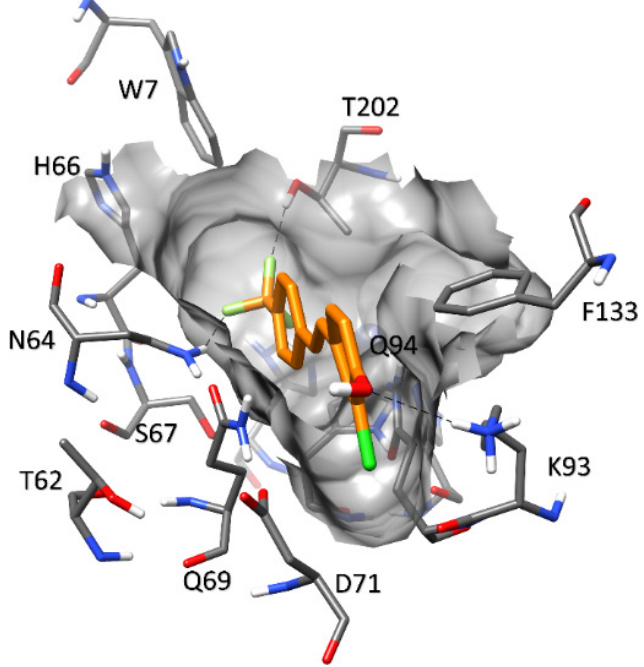
Figure 6. Predicted binding mode of compound 4 in hCA VII.